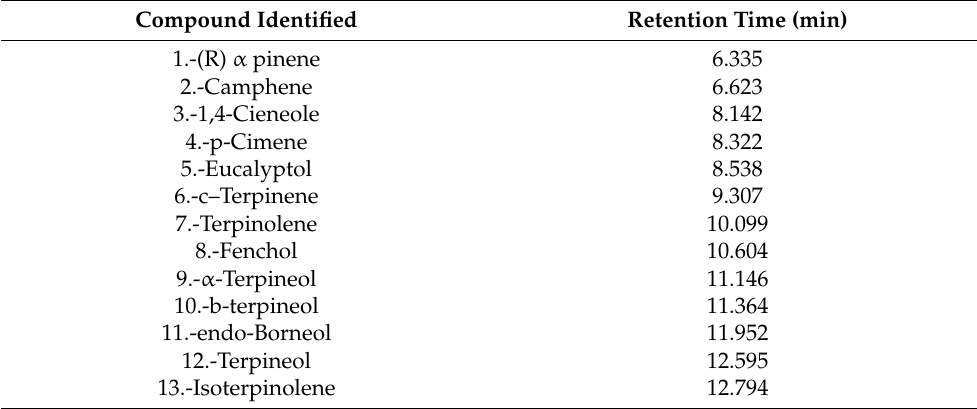
Table 1. Chemical profile of the main compounds of Pinus sylvestris .